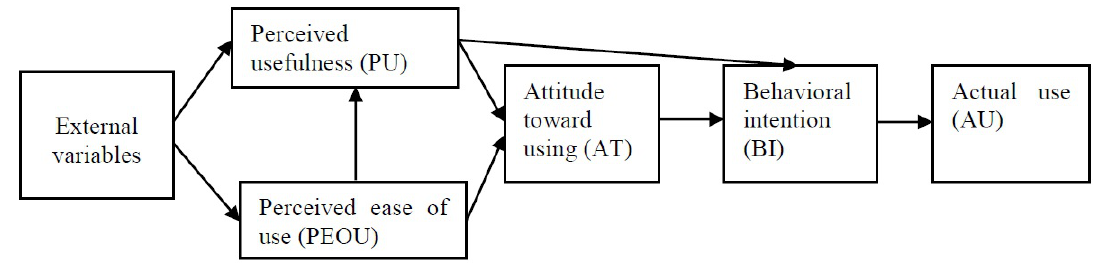
Figure 1. Original Technology Acceptance Model (TAM), adopted from